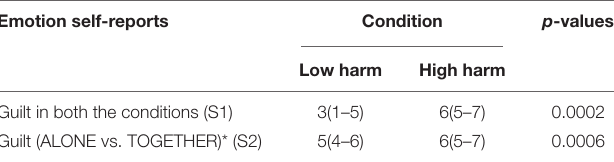
TABLE 1 | Subjective ratings of